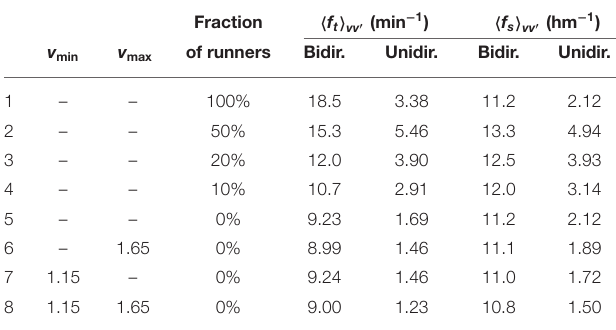
TABLE 1 | The average number of encounters per minute and per 100 m for a track with 100 people per kilometer subjected to different conditions, as defined by Equations (3) and (6).